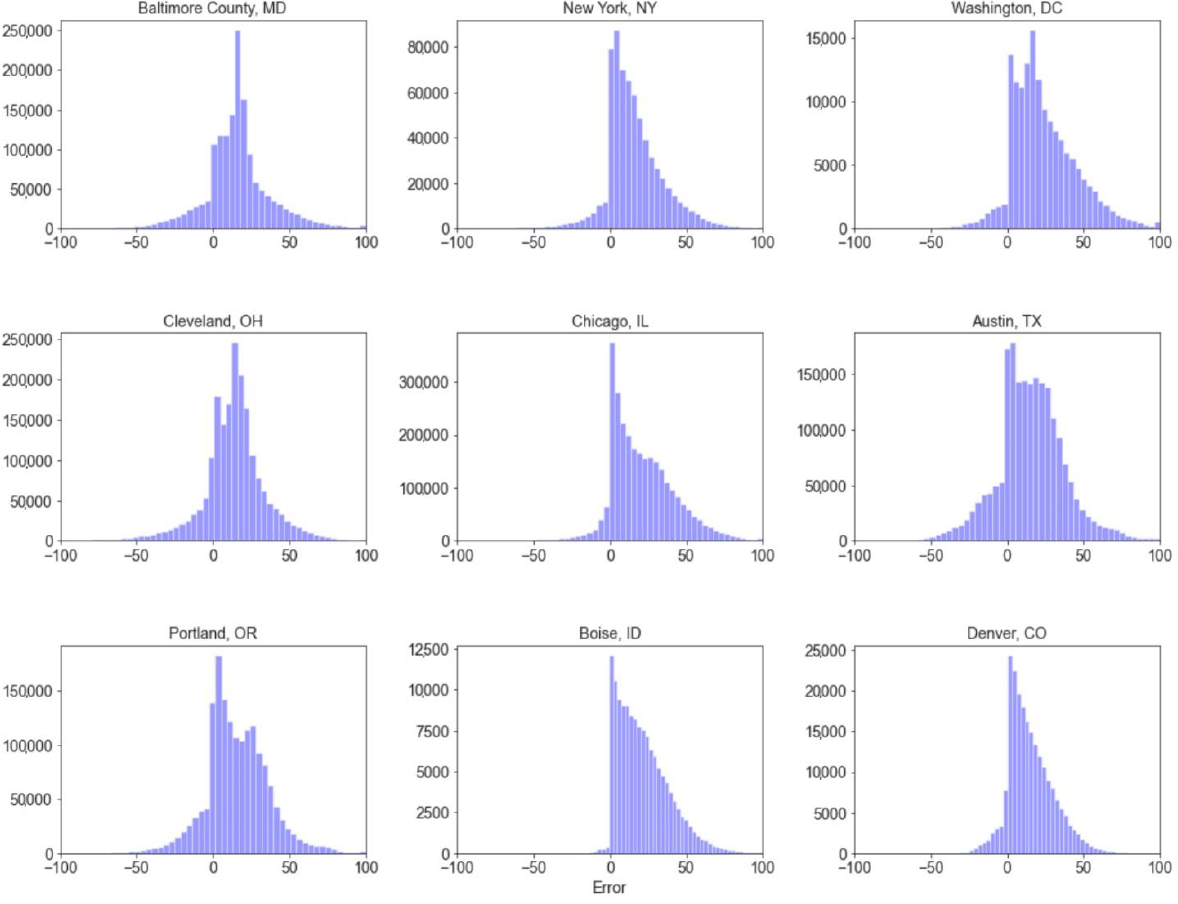
Figure 3. Error (deviation by % when compared to high-resolution derived data) distribution of National Land Cover Database-Tree Canopy 2011 data in selected cities.